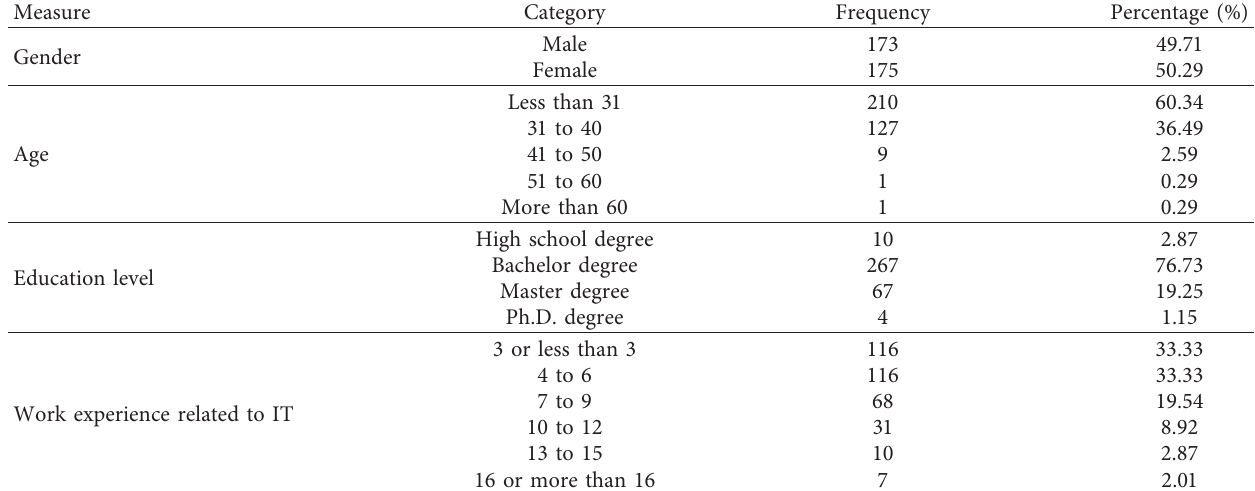
Table 1: Demographics of